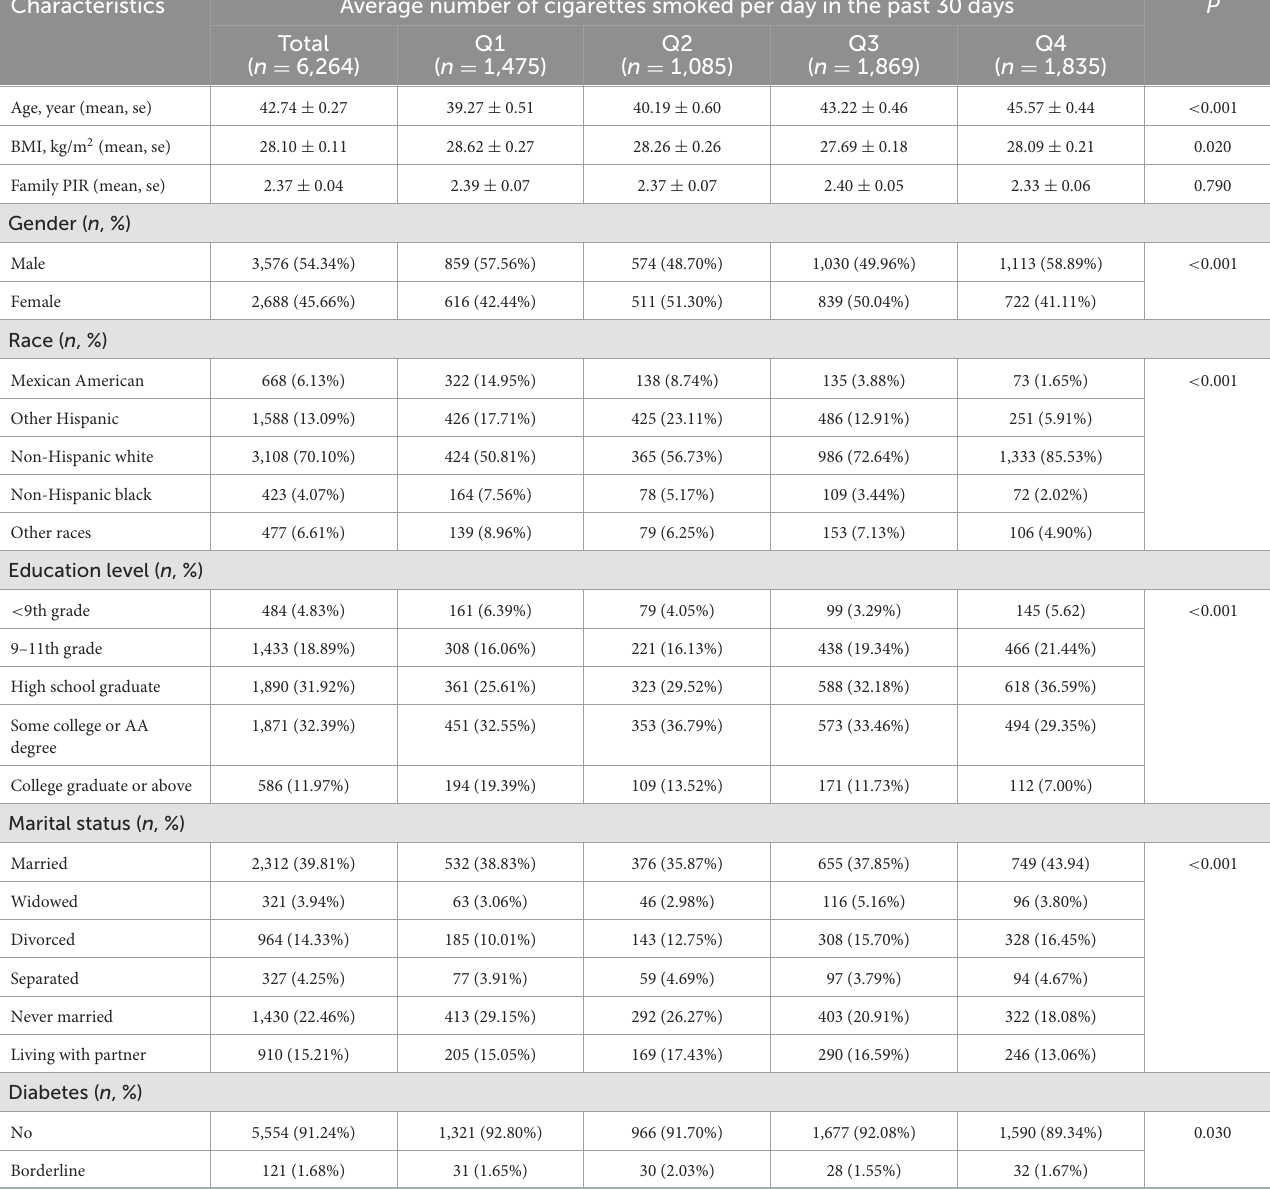
TABLE 4 Baseline characteristics of participants with average daily smoking in the past 30 days.